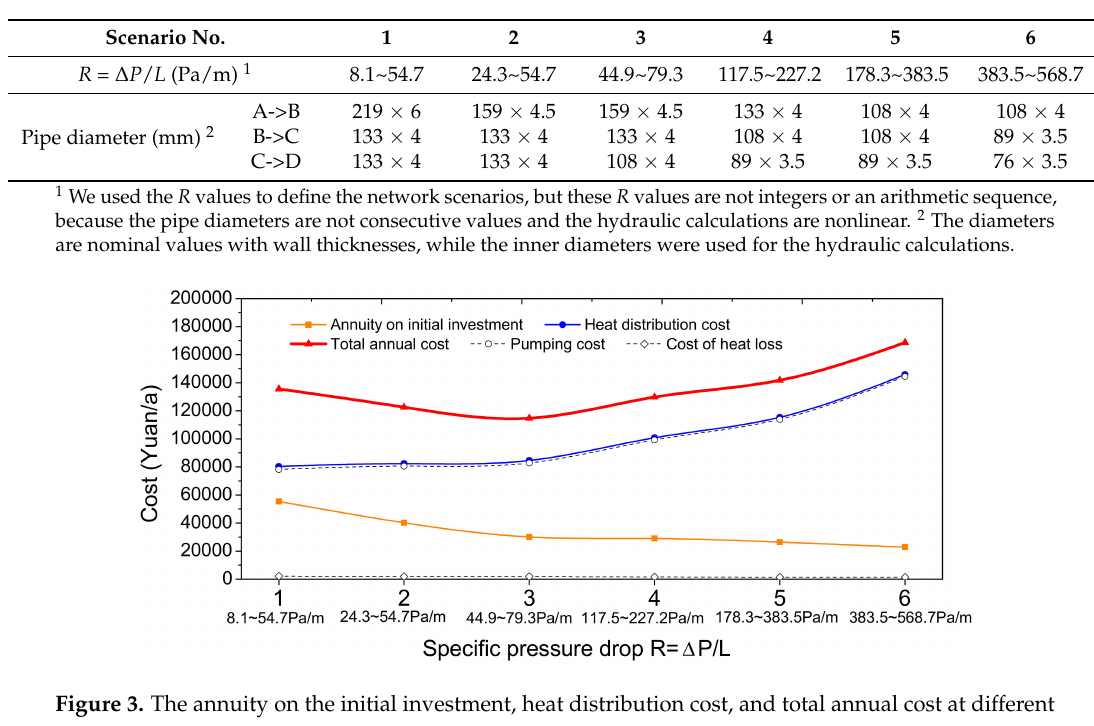
Table 3. The network scenarios for the sample DH network.